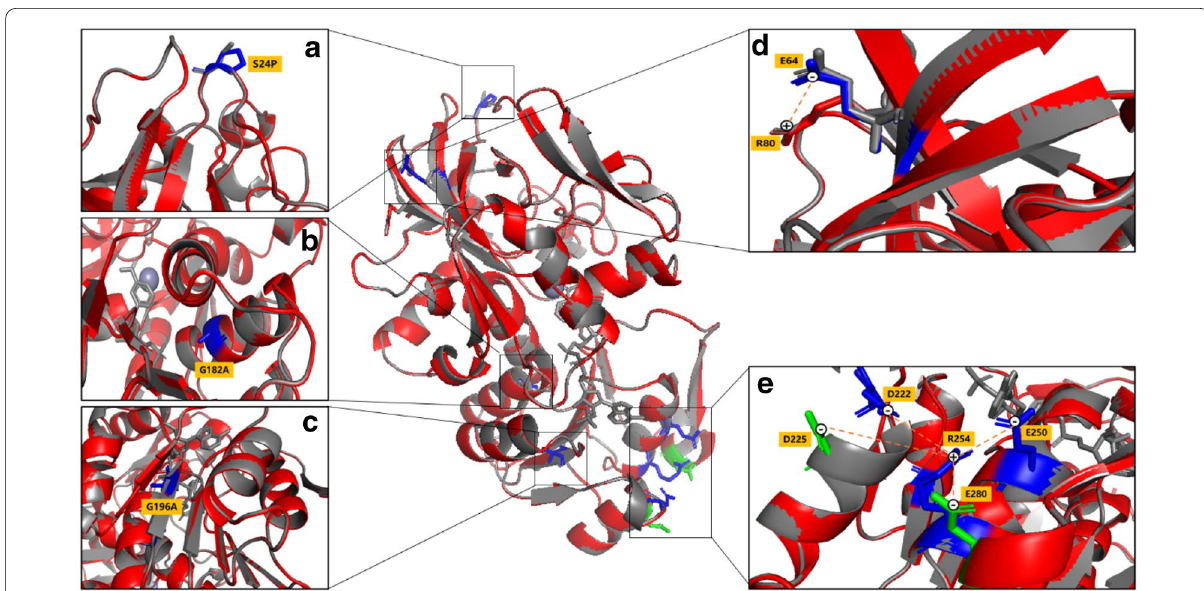
Fig. 5 Protein structure of CbADH-6M (red backbone) compared with the wild CbADH (gray backbone). a The mutant S24P located in the loop region. b The mutant G182A located in the α-helix. c The mutant G196A located at β-sheets. d New salt bridge Glu64–Arg80 formed by CbADH-6M. e Schematic diagram of new salt bridge network centered on